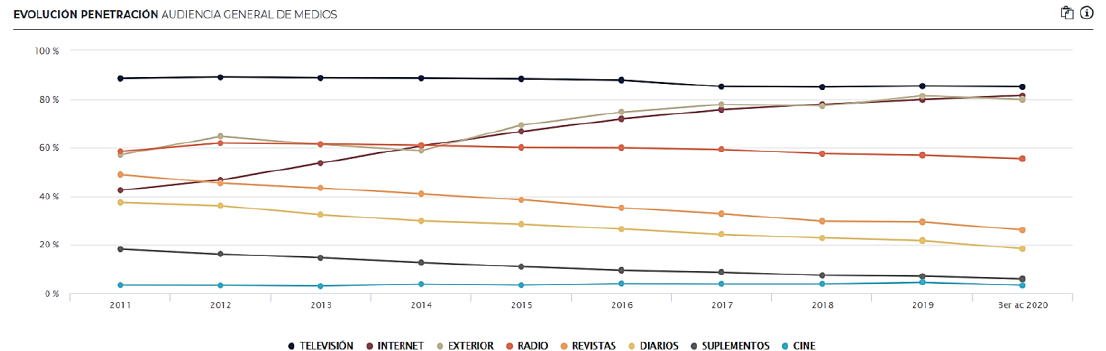
Figure 2. In-print media trend over the last decade according to the EGM. Source: EGM 2020. Source: https://reporting.aimc.es/index.html#/main/cockpit.